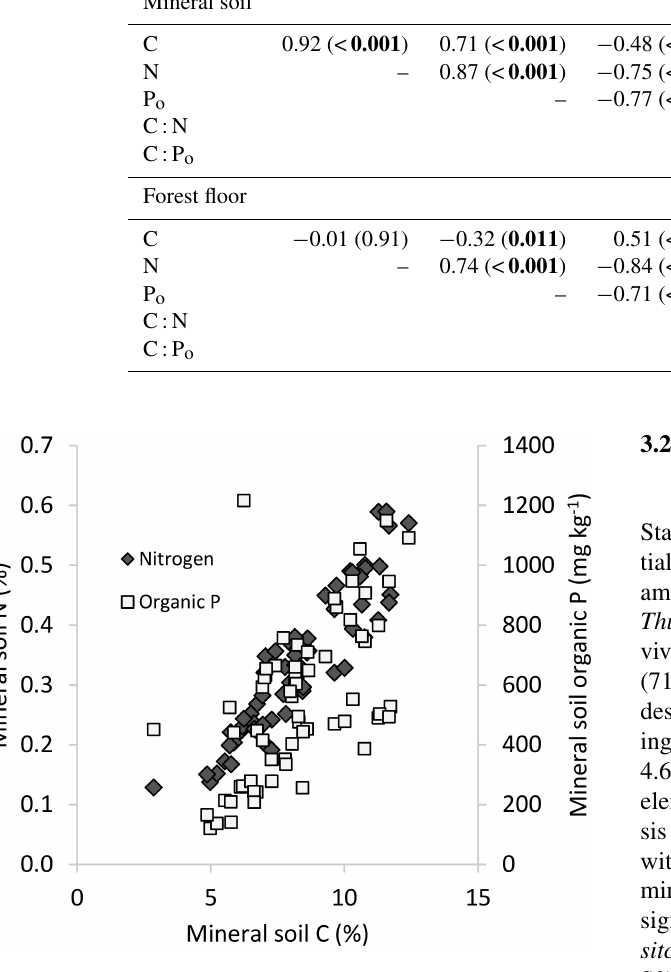
Figure 1. Mineral soil (0–20cm) N and P o concentrations in rela- tion to mineral soil C across the study